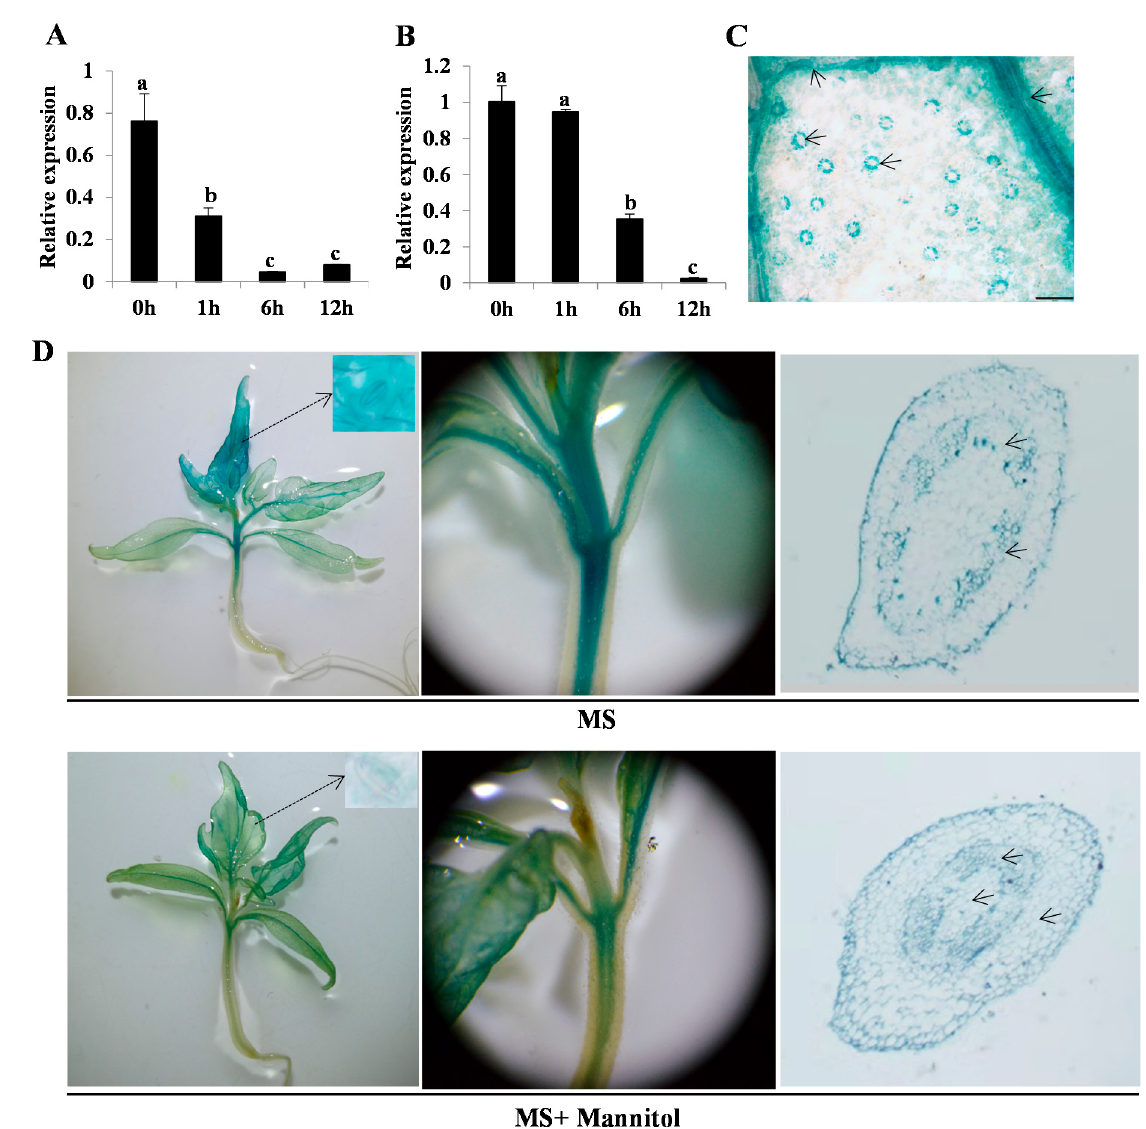
Figure 1. Expression pattern of SlARF4 . Results of quantitative real-time polymerase chain reaction (qRT-PCR) analysis showing that SlARF4 expression is reduced by ( A ) water deficit and ( B ) abscisic acid (ABA) treatment. Four-week-old tomato seedlings were treated with 100 µ M ABA or by desiccation for different durations; whole seedlings were used for RNA extraction. Polyubiquitin (UBQ) (Solyc01g056940) was used as an internal standard. Data was means ± standard error (SE) of three independent biological replicates. Different letters (a, b, c) presented significant difference at level set p < 0.05; ( C ) Detection of SlARF4 promoter activity in tomato leaves by histochemical GUS staining. ( D ) Detection of SlARF4 promoter activity in tomato seedlings under normal and water stress conditions. Two-week-old seedlings harboring the pARF4::GUS transgene grown in MS and MS plus mannitol media were subjected to GUS staining. Aboveground part of aseptically cultured pARF4::GUS seedlings grown for 3 weeks ( left ); enlarged view of the middle and upper part of the stem ( center ), paraffin section of the stem observed microscopically at 10 ( right ). Black arrow indicates the stomata and xylem. MS medium; MS + 100 µ M mannitol medium. The dot arrows indicates the